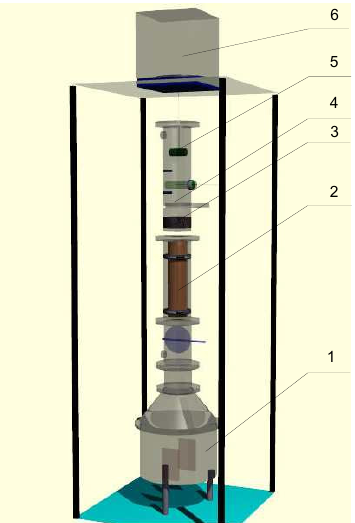
Figure 2. Schema of a setup for sorption isobar measurement at atmospheric pressure built at Lodz University of Technology [15]: 1—boiler, 2—superheater, 3—calming section, 4—steam temperature measurement, 5—sample, and